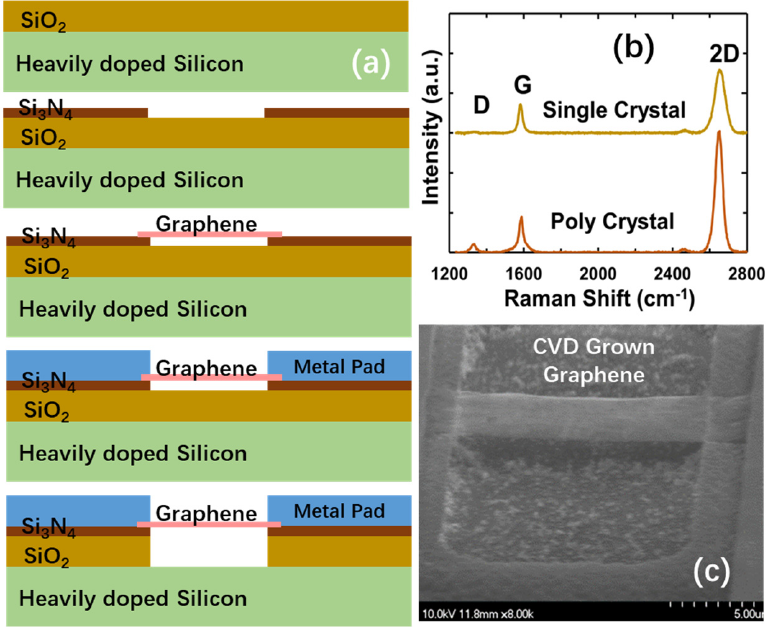
Figure 5. gNEMS fabrication process: ( a ) CMOS-compatible fabrication procedure; ( b ) Ramen spectrum confirming graphene materials and distinguishing single-crystalline and poly-crystalline graphene structures; ( c ) SEM image of gNEMS structure showing the suspended graphene ribbon over the cavity.